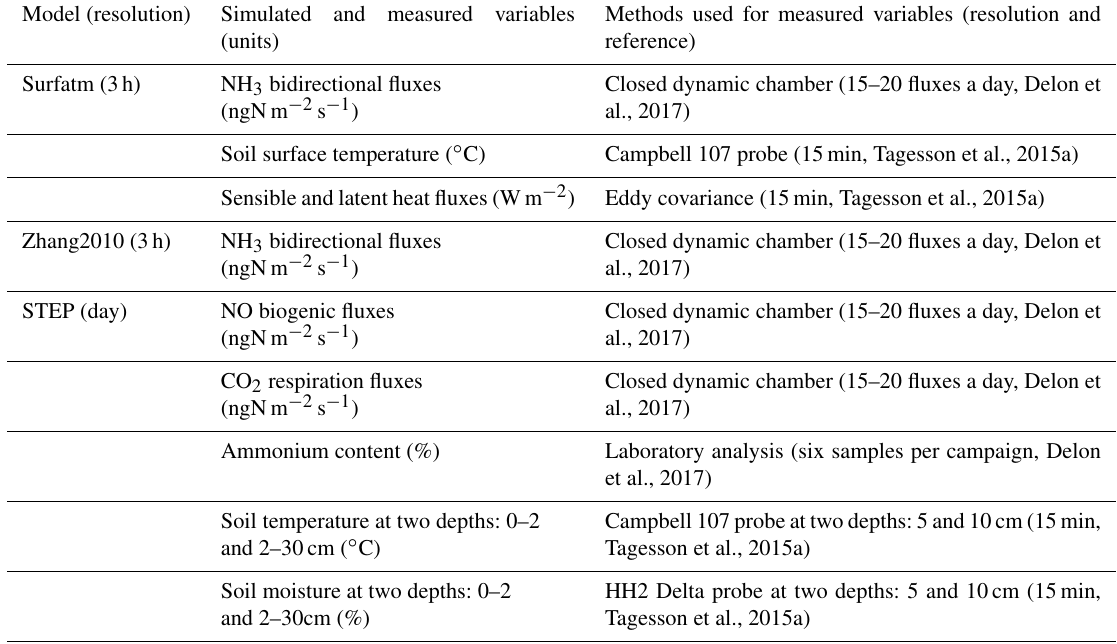
Table 1. Summary of different models used in the study, with the variables simulated and compared to measurements. All simulated and measured variables were daily averaged for the purpose of the